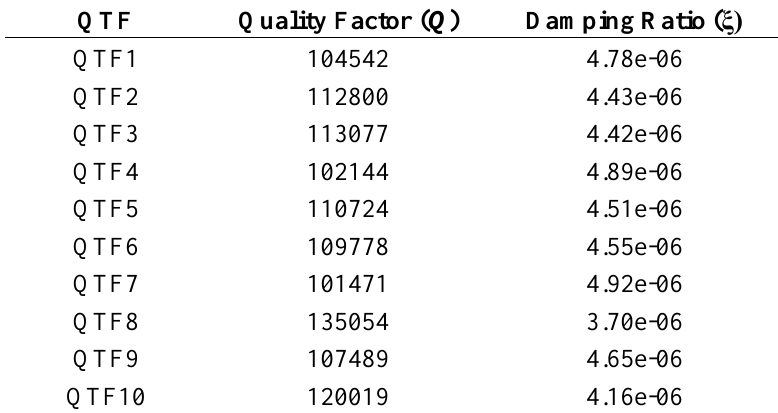
Table 2. Quality factor of the ten QTF. Q values were experimentally measured, and implemented in FEM through the damping